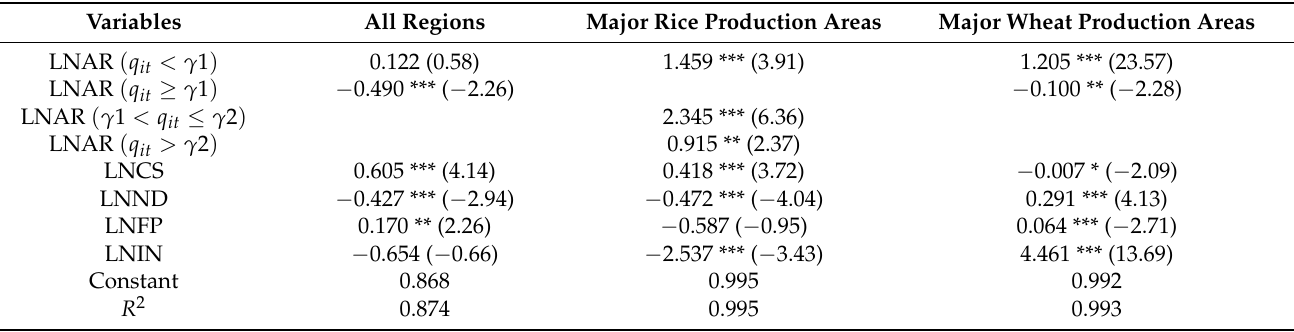
Table 6. Threshold effect regression